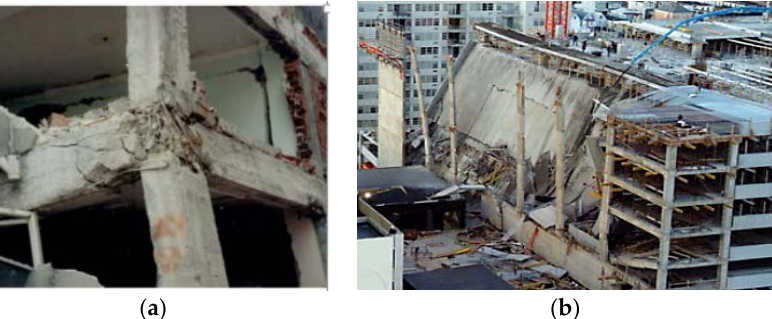
Figure 1. Failure of RC buildings due to different extreme loading [3]. ( a ) Beam-column conncetion failure. ( b ) Slab-column connection failure.